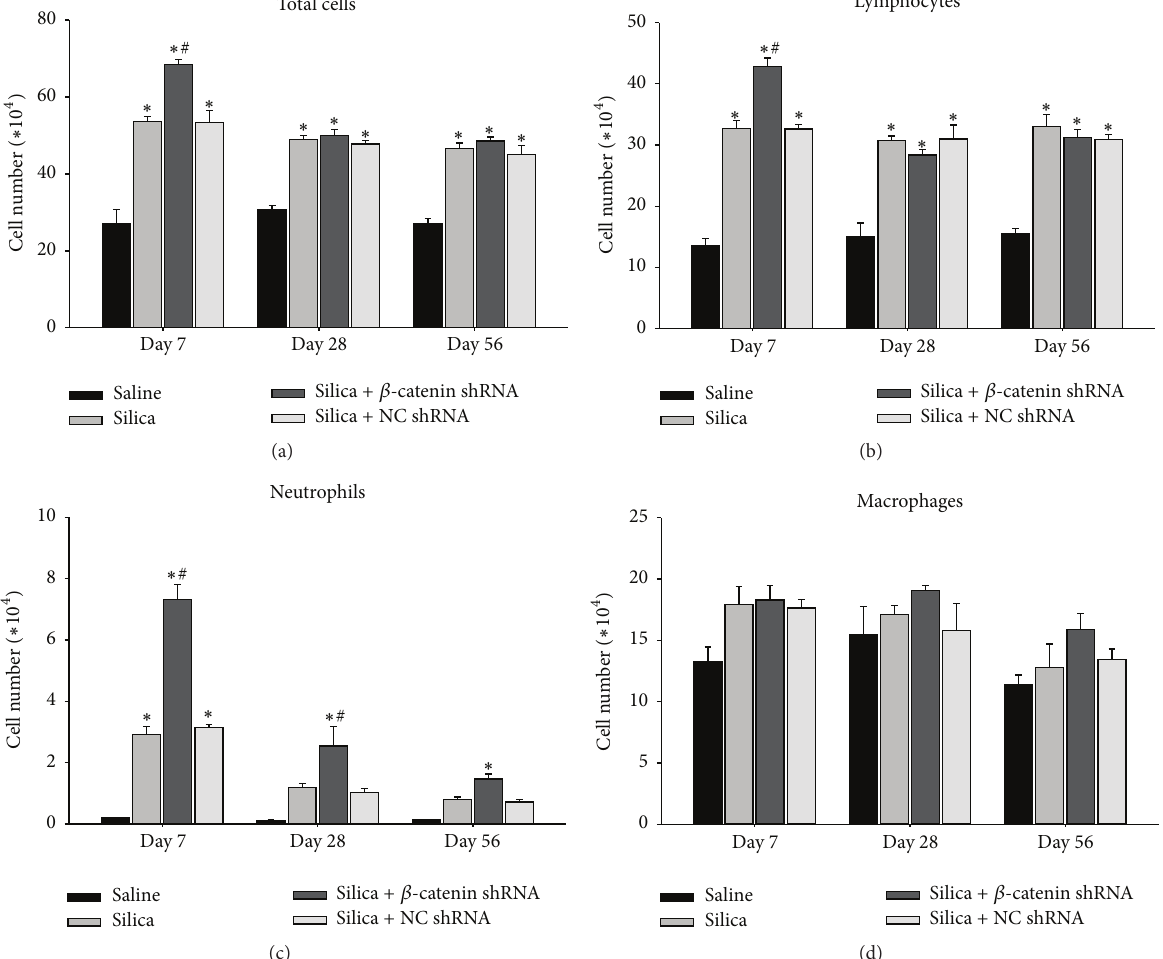
Figure 2: Blockade of Wnt/ 𝛽 -catenin pathway increased the accumulation of inflammatory cells. Total cells (a), lymphocytes (b), neutrophils (c), and macrophages (d) in BALF were counted by using Wright-Giemsa staining. Values are shown as mean ± SEM ( 𝑛 = 5 ) ( ∗ , as compared with saline group at the same time point, 𝑝 < 0.05 ; #, as compared with silica group and silica + NC shRNA group at the same time point, 𝑝 < 0.05 ).